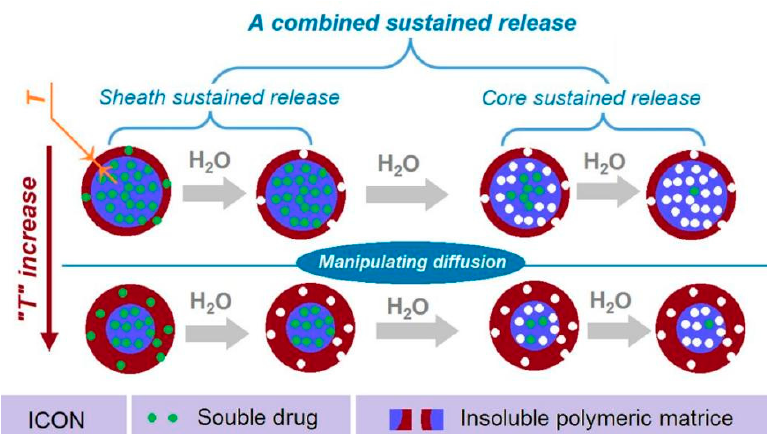
Figure 10. A diagram showing the combined strategy, which is aimed for providing a better sus- tained release profile of water-soluble